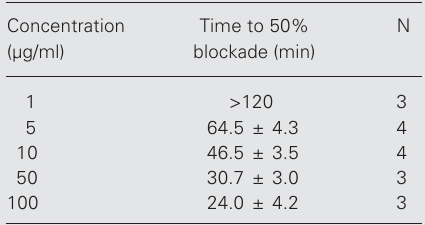
Table 1. Time to 50% blockade by Bothrops neuwiedii pauloensis venom of twitches